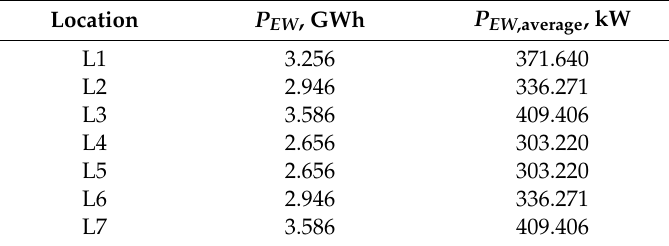
Table 7. O ff shore wind energy